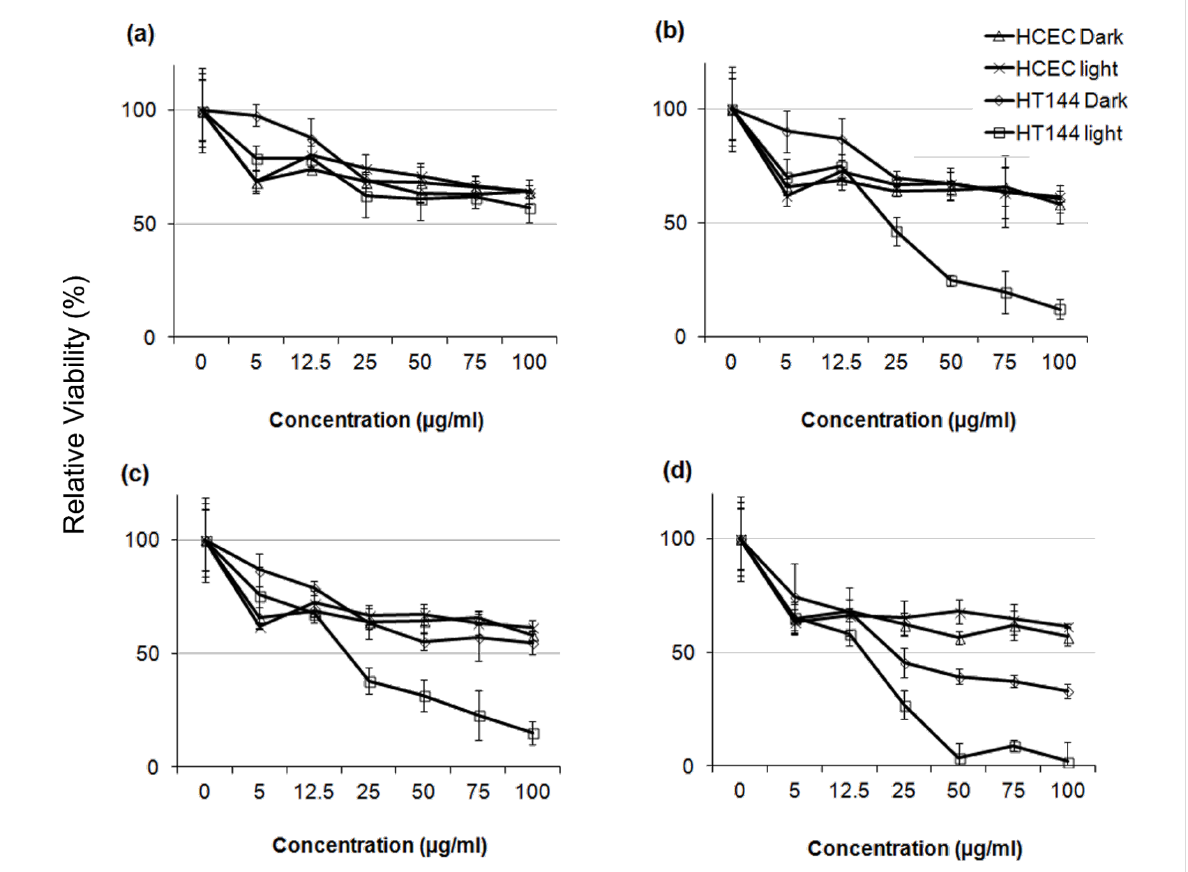
Figure 5: Comparison of the effect of ZnO and ZnO:Ag nanocomposites on mitochondrial function (MTT reduction) in HT144 (skin cancer) and HCEC (normal) cells. Exponentially growing cultures were treated with different concentrations (5, 12.5, 25, 50, 75, 100 µg/mL) of the nanoparticles and in order to analyze the photo-oxidative effect of nanoparticles, the cultures were exposed to daylight or kept in dark at 37 °C for 15 min and further incu- bated for 24 h. MTT reduction (mean ± SD) was measured. NTC were included as control. (a) ZnO, (b) ZnO:Ag (10%), (c) ZnO:Ag (20%), and (d) ZnO:Ag (30%). The experiment was performed twice with triplicates of each sample.